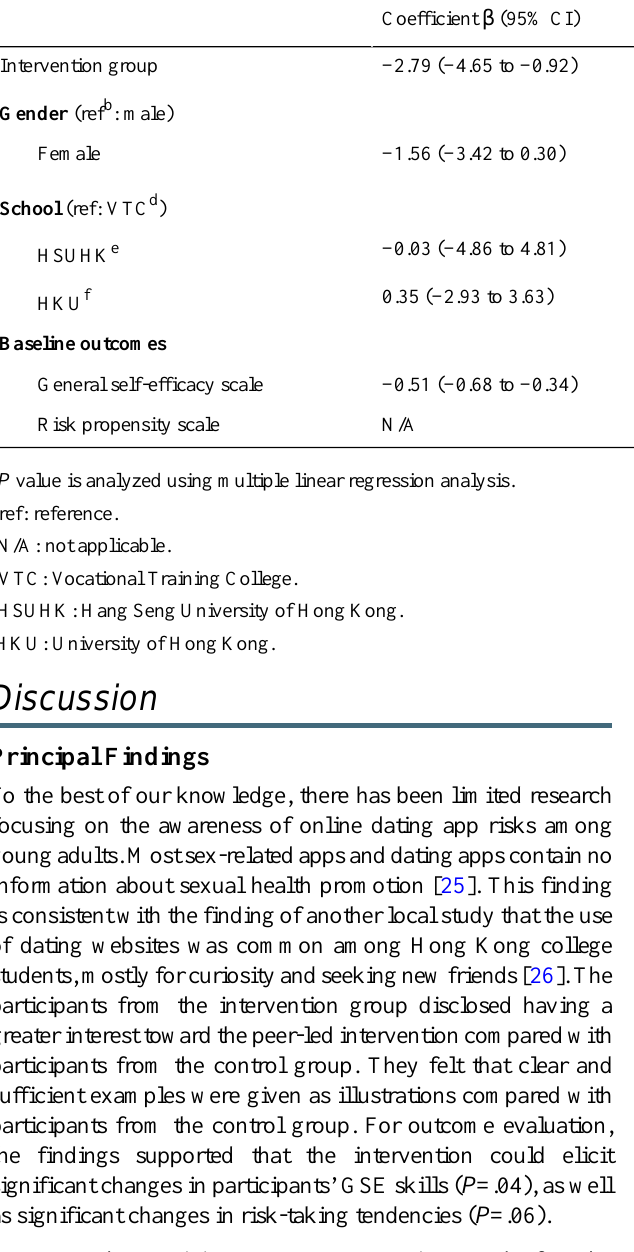
Risk propensity scale scoreGeneral self-efficacy scale